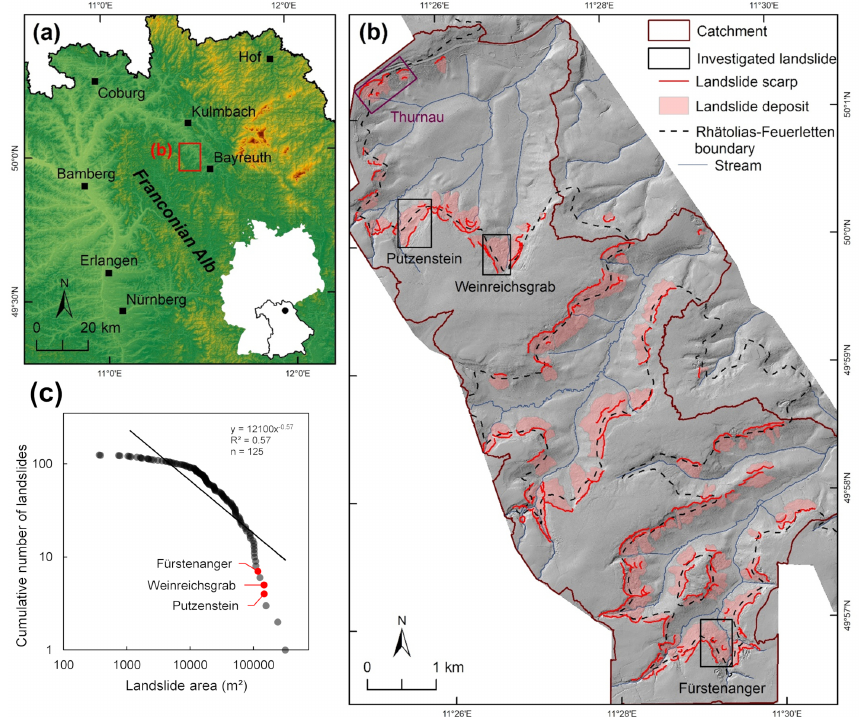
Figure 2. (a) Location of the research area at the Franconian Jura (source: Bayerisches Landesamt für Digitalisierung, Breitband und Vermessung). (b) Mapped landslides based on Bayerisches Landesamt für Umwelt (2020) and own mapping including investigated landslides (source: Bayerisches Landesamt für Digitalisierung, Breitband und Vermessung). (c) Frequency–magnitude relationship of landslides.